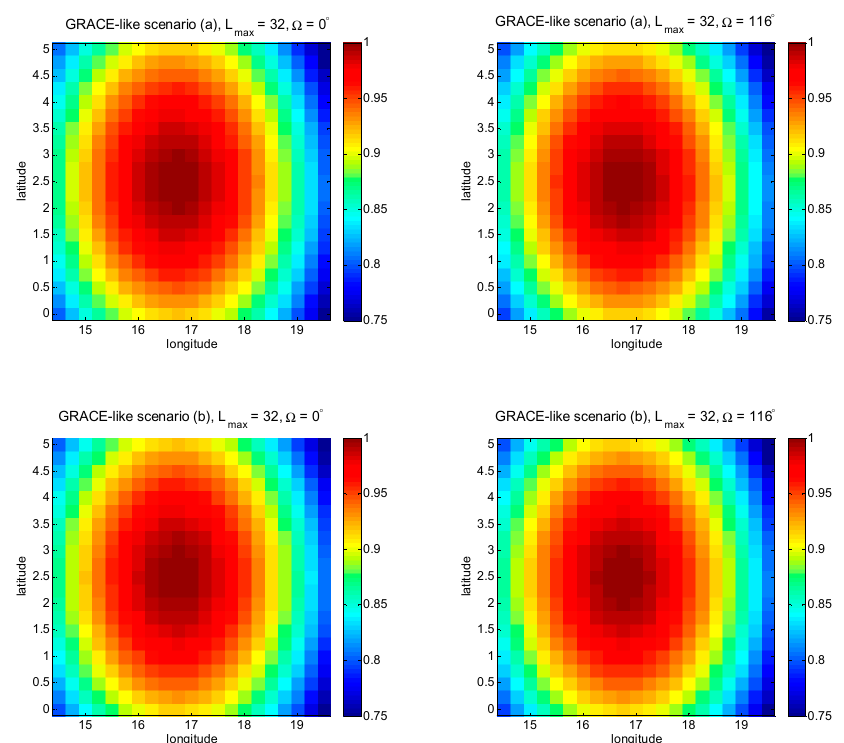
Figure 21. Spatial covariance of a selected point in West Africa (from Figures 19 and 20) for 6-day solution of the inline formation up to L max = 32, for top: scenario (a), and bottom: scenario (b). Left is Ω = 0 ° and right is Ω = 116°.